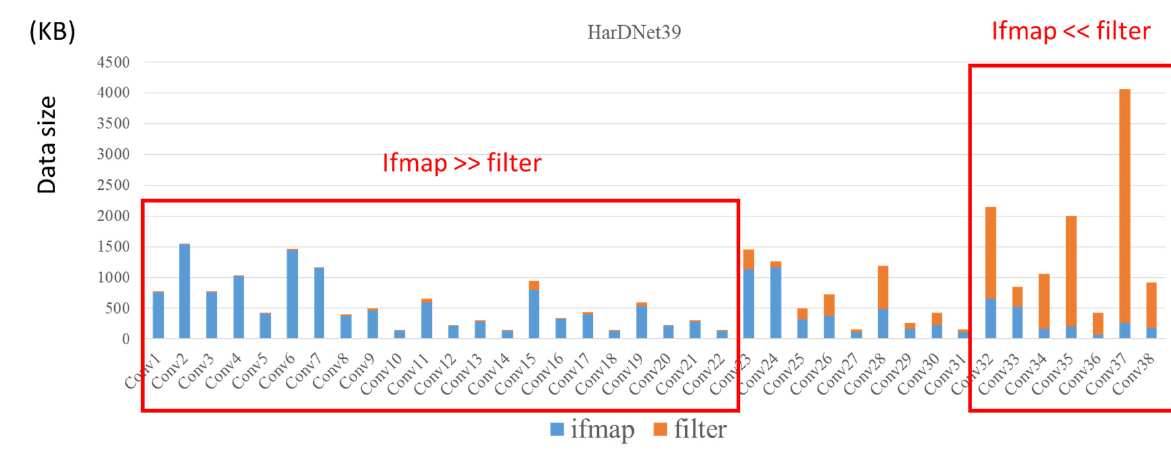
Figure 2. Data size distribution of HarDNet39.